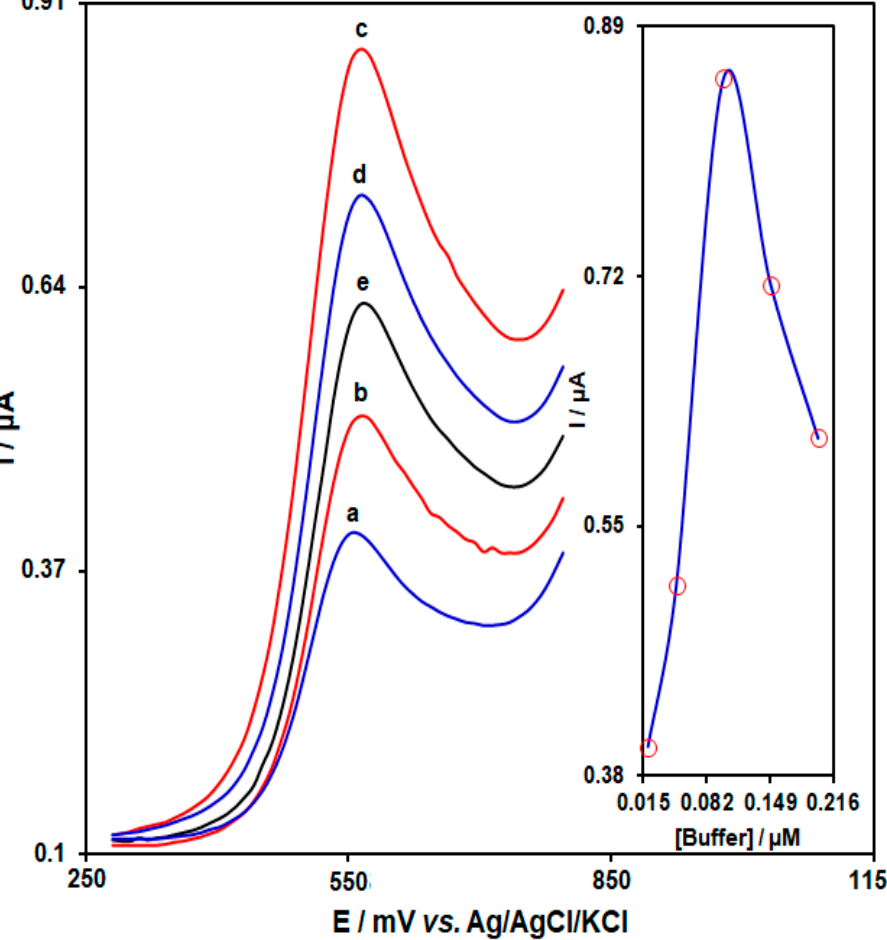
Figure 5. DPVs captured from AP/Au-NS/CPE with the aptamer concentration of 4.5 μ M, interac- tion time of the aptemer with homocysteine of 65 min in PBS (pH 7.0) with variable phosphate buffer concentrations. a–c: (a) 0.02, (b) 0.05, (c) 0.1, (d) 0.15, and (e) 0.2 M, sequentially. Inset: plot of peak current versus variable phosphate buffer concentrations.